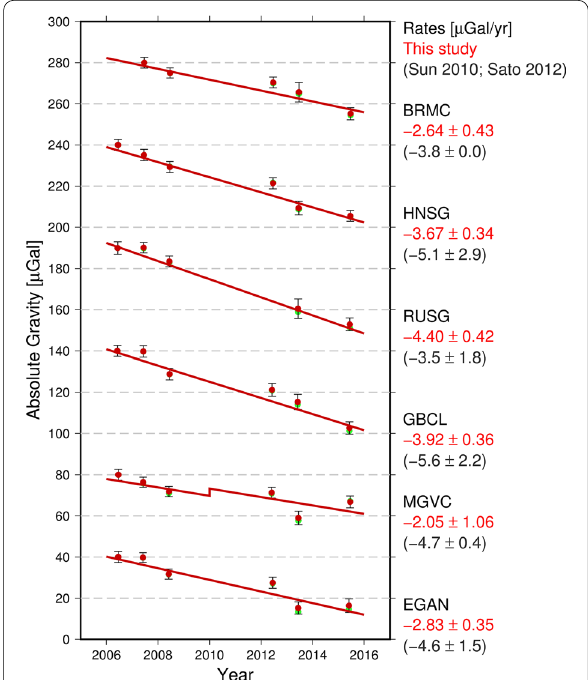
Fig. 5 AG and its variation rate at six AG points in SE-AK from 2006 to 2015. Green/red circles indicate the AG before/after the effects of hydrological and coseismic gravity changes were corrected. An arbitrary constant value was subtracted from the AG for each gravity point, so as to draw all of the AG data in this figure. Note that the AG at RUSG in 2012 was not shown because of the large error associated with the instrumental failure. The vertical bar for each red circle indicates the error value of the corresponding AG data calculated as the root sum square of SD and UC (see Table 2). The red line for each AG point indicates the regression line to the AG measured from 2006 to 2015 (red circles) and its variation rate with its standard deviation is shown as a red value on the right side of the figure. For the gravity point of MGVC, the amplitude of the gravity step between 2008 and 2012 was also calculated associated with the relocation of the gravity point in Mendenhall Glacier Visitor Center. Gray-colored values on the right side of the figure indicate the gravity variation rates determined in the earlier studies (Sun et al. 2010; Sato et al.